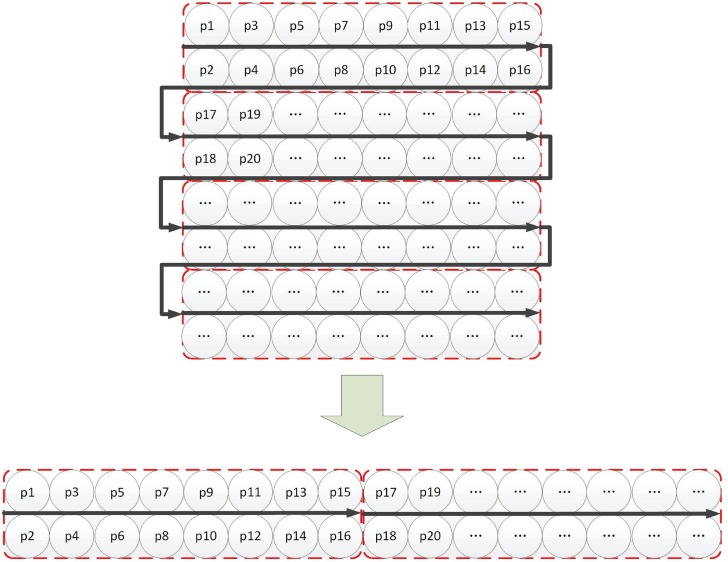
Form changing of dependent encryption.